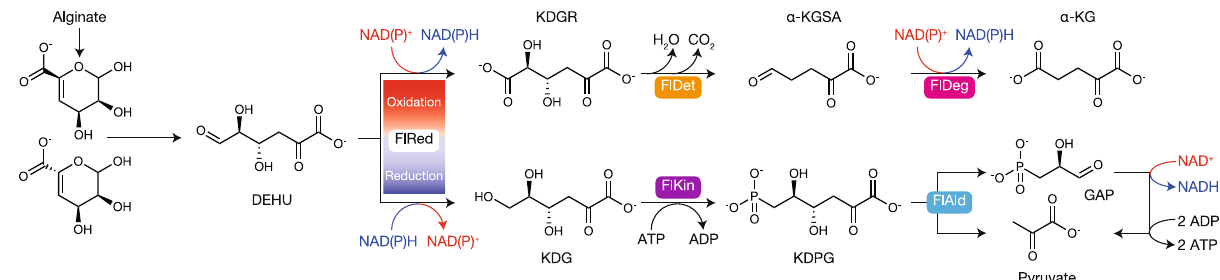
Fig. 5 Dual metabolic pathways of DEHU in strain UMI-01. Unsaturated monosaccharides are generated from alginate by alginate lyase(s) and are spontaneously or enzymatically 51 transformed into DEHU. DEHU is oxidized (upper) or reduced (lower) by FlRed with NAD(P) + or NAD(P)H. Final products of oxidation and reduction pathways are α -KG and pyruvate, respectively.